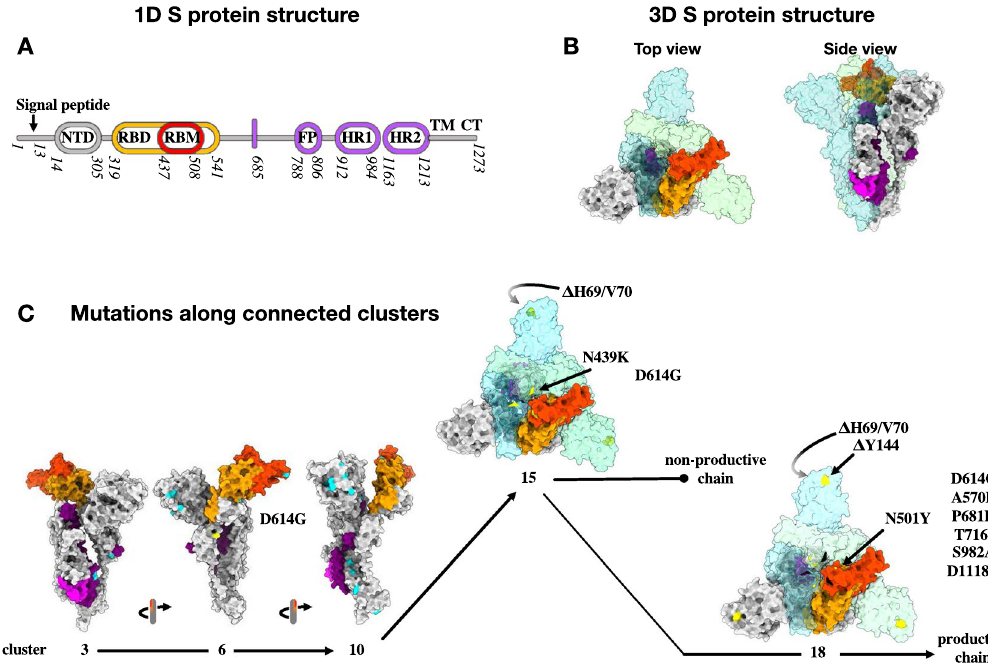
Figure 4. Temporal analysis of mutations arising in the Spike protein during the genesis of the Alpha VoC. ( A ) Schematic representation of the SARS-CoV-2 Spike protein (S): N terminal domain (NTD); receptor binding domain and motif (RBD and RBM, respectively); fusion peptide (FP); heptad repeat 1 and 2 (HR1 and HR2, respectively); transmembrane domain (TM) and cytoplasmic tail (CT). ( B ) Top and side view of the trimeric Spike protein in its closed conformation 43 (PDB: 6ZGI). For simplicity, the colour codes of the different domains are provided for a single chain of the trimer. ( C ) Accumulation of the different mutations in the different clusters leading to the establishment of the Alpha VoC: domains colour codes as in ( A ) for a single S; yellow indicates mutations fixed in the dominant variant and cyan indicates mutations appearing in subdominant ones. In cluster 14 ( r W = 100 ), the original position of the N439K mutation that was lost to the profit of the near N501Y mutation is marked in